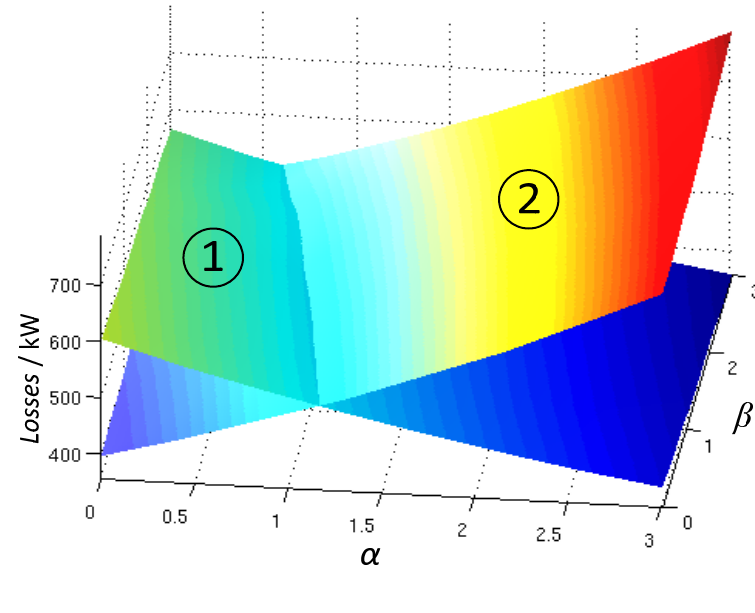
Figure 2. Losses with respect to coefficients α and β and OLTC feeding